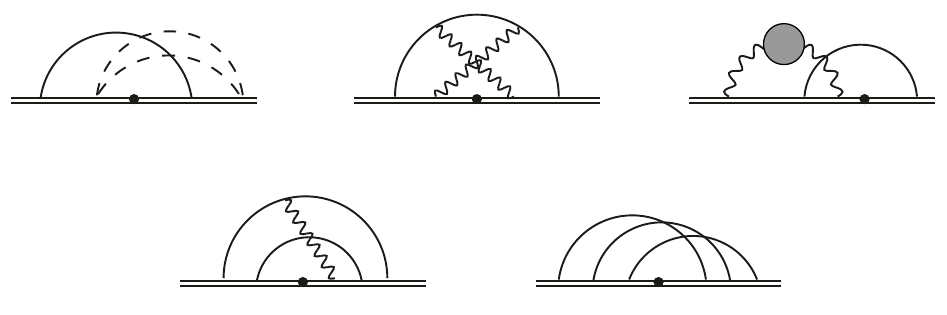
Figure 12 . Nonplanar